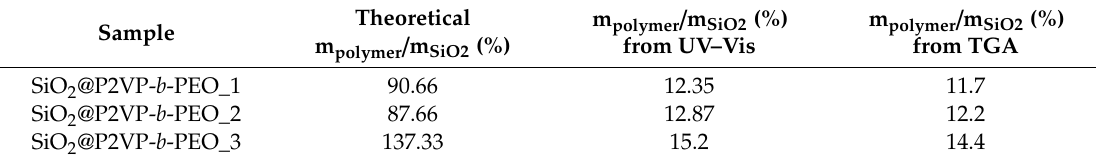
Quantitative analysis of the adsorbed poly(2-vinyl pyridine)- b -poly(ethylene oxide) (P2VP- b -PEO) through ultraviolet–visible light (UV–Vis) spectroscopy and thermogravimetric analysis